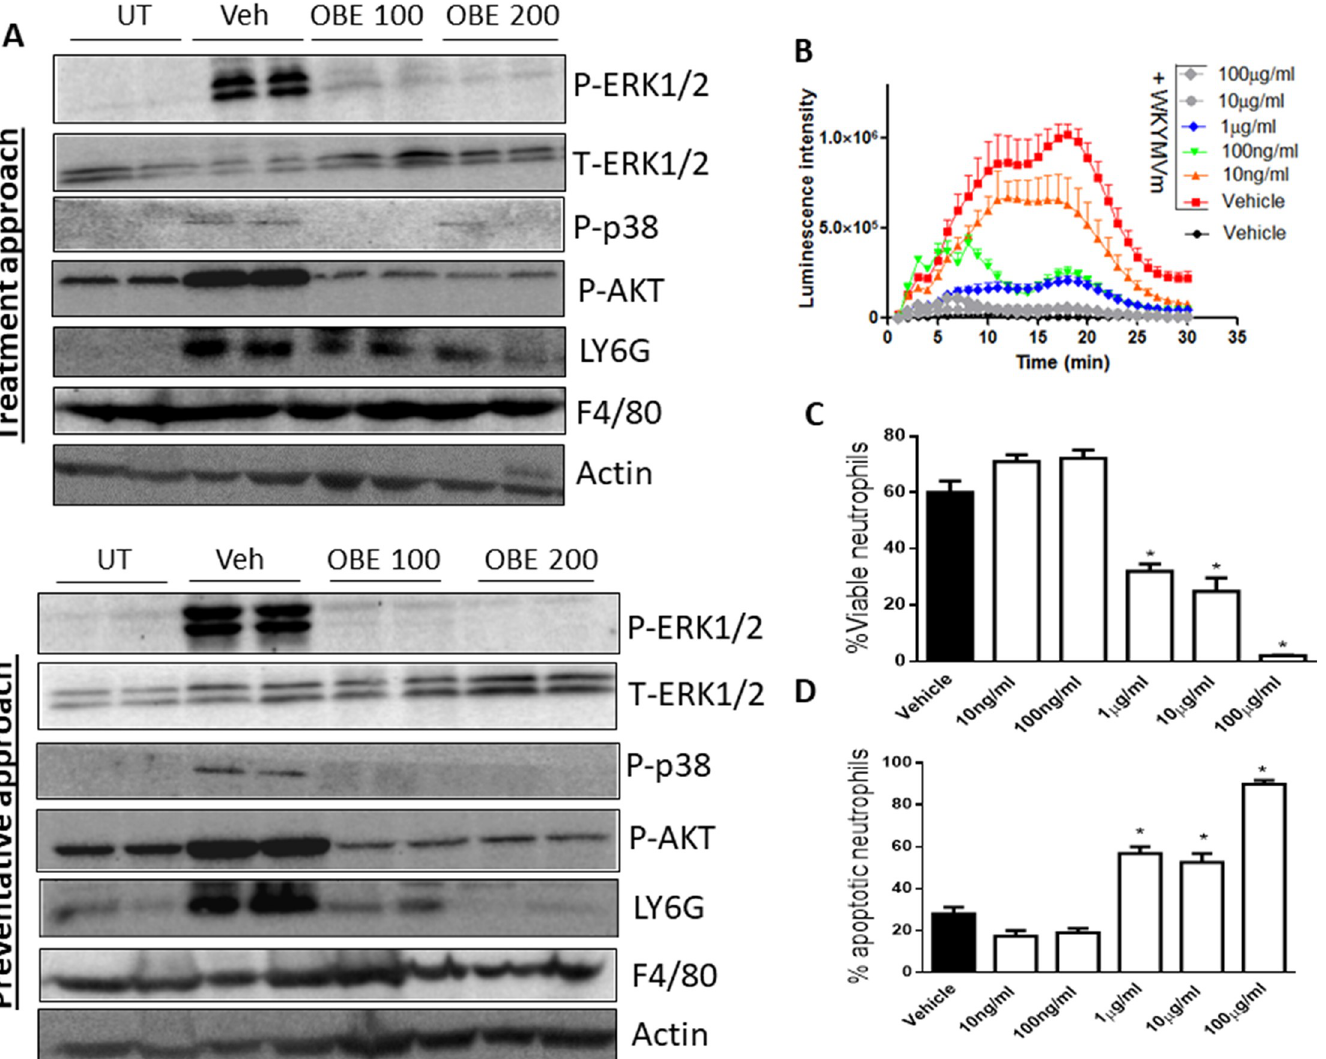
Fig 9. Effect of OBE on the expression/activity of pro-inflammatory molecules and immune cell markers, and neutrophil superoxide release and spontaneous apoptosis in vitro . Colon sections taken from mice treated for with DSS/vehicle, DSS/OBE (100–200 mg/kg) or untreated (UT) mice were immunostained with antisera against phosphorylated/total ERK1/2, AKT, p38, LY6G, F4/80, or actin (Panel A). The blots represent one of 3 similar experiments. Neutrophils were isolated from na ï ve mice and the level of superoxide release was determined by recording chemiluminescence emanating from oxidation of luminol substrate. Neutrophils were treated with vehicle only (solid circles), or 10 μ M WKYMVm plus vehicle (red squares) or various concentrations of OBE (panel B). The % of viable (panel C) and % apoptotic (panel D) neutrophils in response to vehicle (open bar) or various concentrations of OBE (hatched bars) was determined using Annexin-V/7AAD assay. Histobars represent means ± SEMs for 3 independent experiments conducted with cells isolated from 3 mice in each group. Asterisks denote significant difference from vehicle group, with p < 0.05.